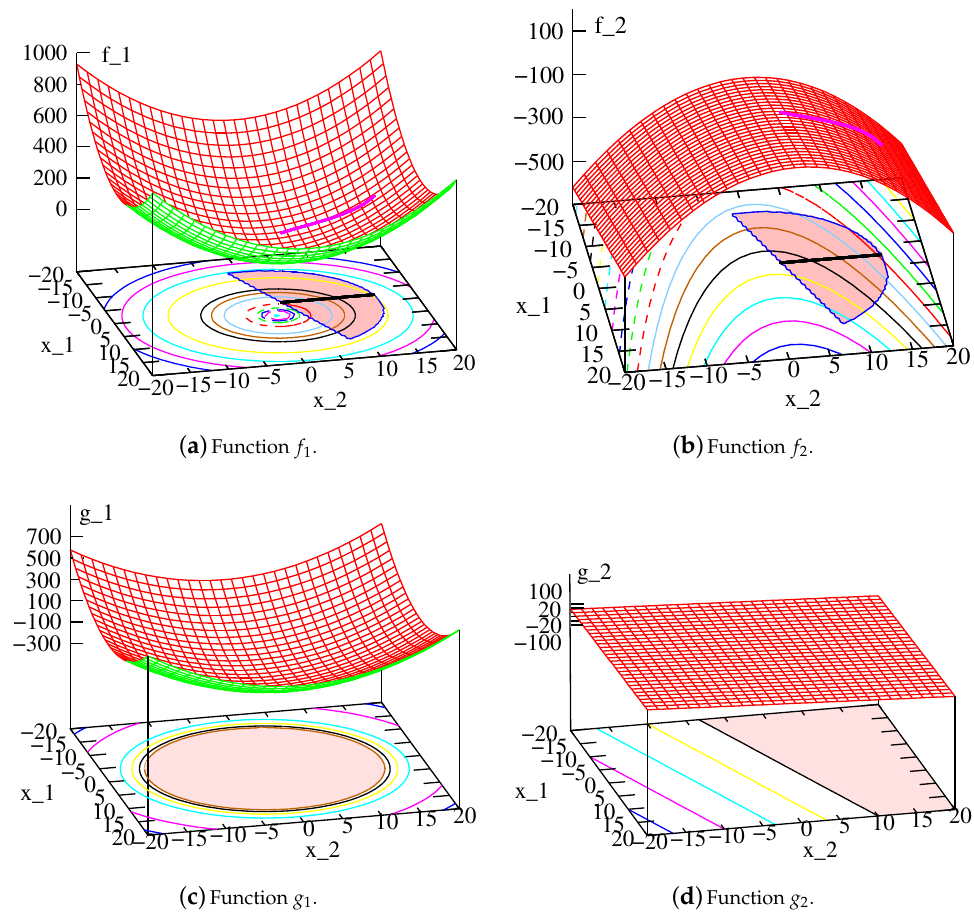
Figure 2. Two objectives and two constraints are shown for SRN problem. The combined fea- sible region is shown in the contour plot. PO solutions lie on the black line marked inside the feasible